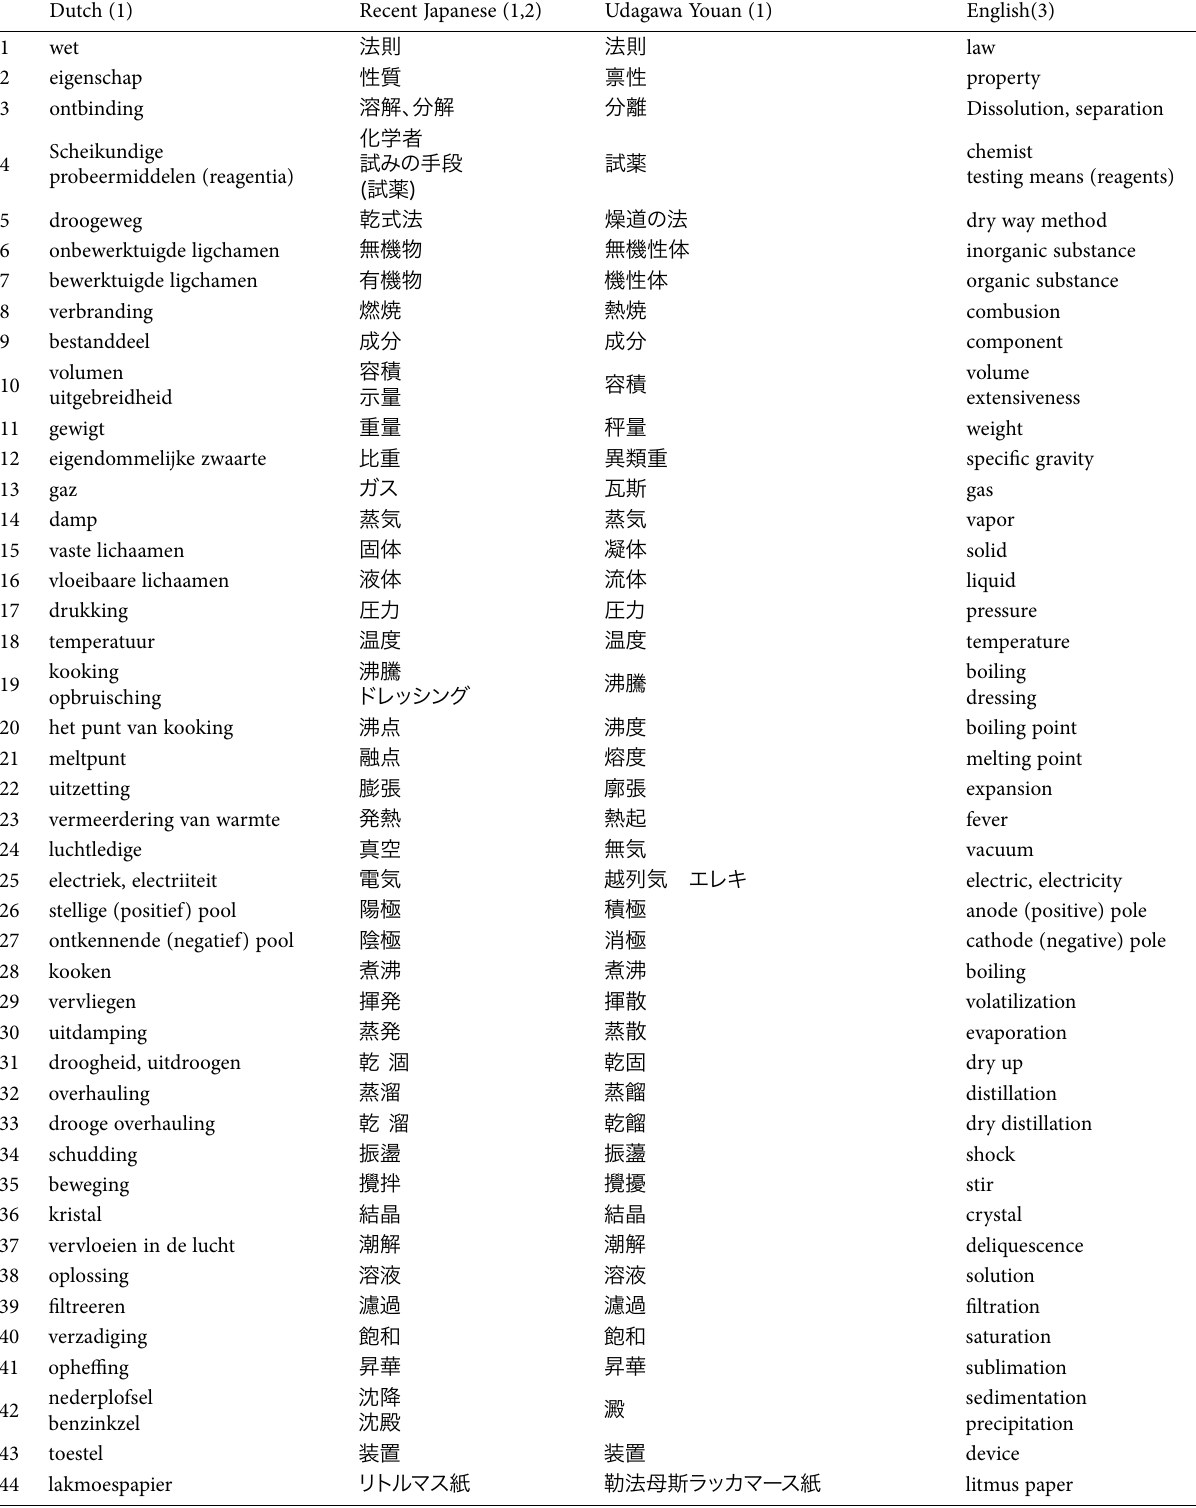
Table 1. Current and Youan’s chemistry terms, Dutch terms he studied and their English translation. Dutch